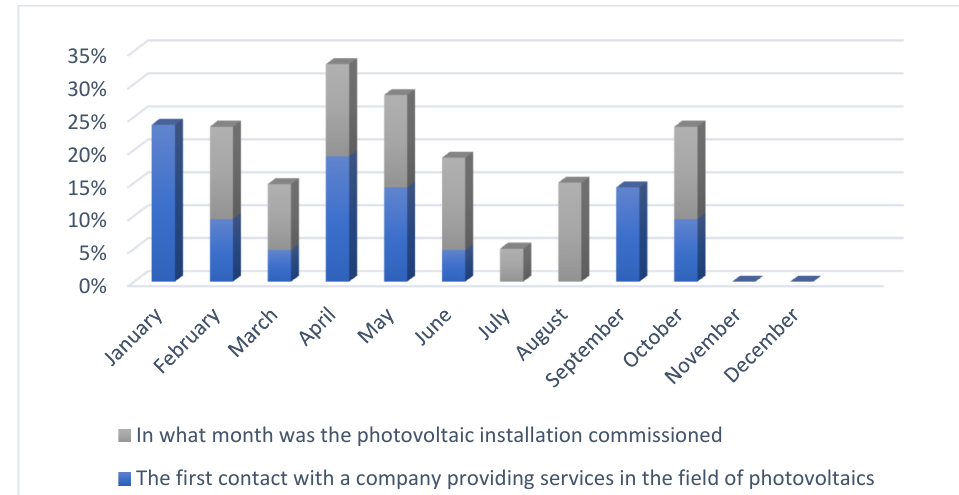
Figure 4. Time-decision process of purchasing a photovoltaic installation.